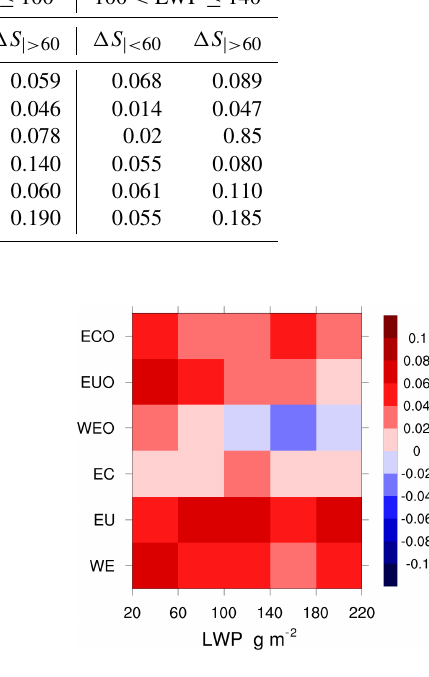
Figure 6. The differences between CER 2 . 1µm –AOD (AI) slope and CER 3 . 7µm –AOD (AI) slope under all LWP bins over three anthro- pogenic regions (EC, EU, and WE) and their adjacent oceans (ECO, EUO, and